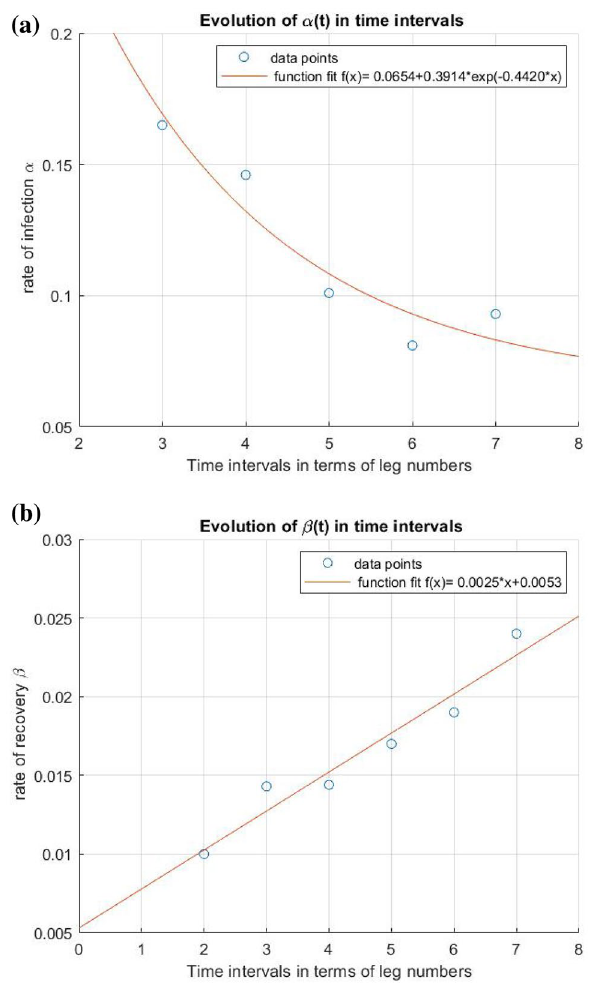
Figure 10. Curve fitting for studying the evolution of α and β over time. ( a ) α (t) being fit to an exponential 0.4420 x decay function y ( x ) = 0.0654 + 0.3914 · e − ( b ) β( t ) being fit yo a straight line y ( x ) = 0.0025 x +